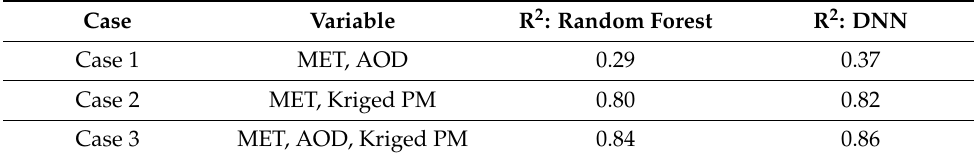
Figure 4. Incorporating local source variables to potentially improve spatial Kriging. Regression score is plotted as a function of mean distance from the target location to all other locations. Regression was calculated from the hourly kriging results from September through December of 2016. ( a ) Random forest regression Kriging; ( b ) deep neural network (DNN) used to post processes simple Kriging results. Table 2. The interpolation results from different input and method